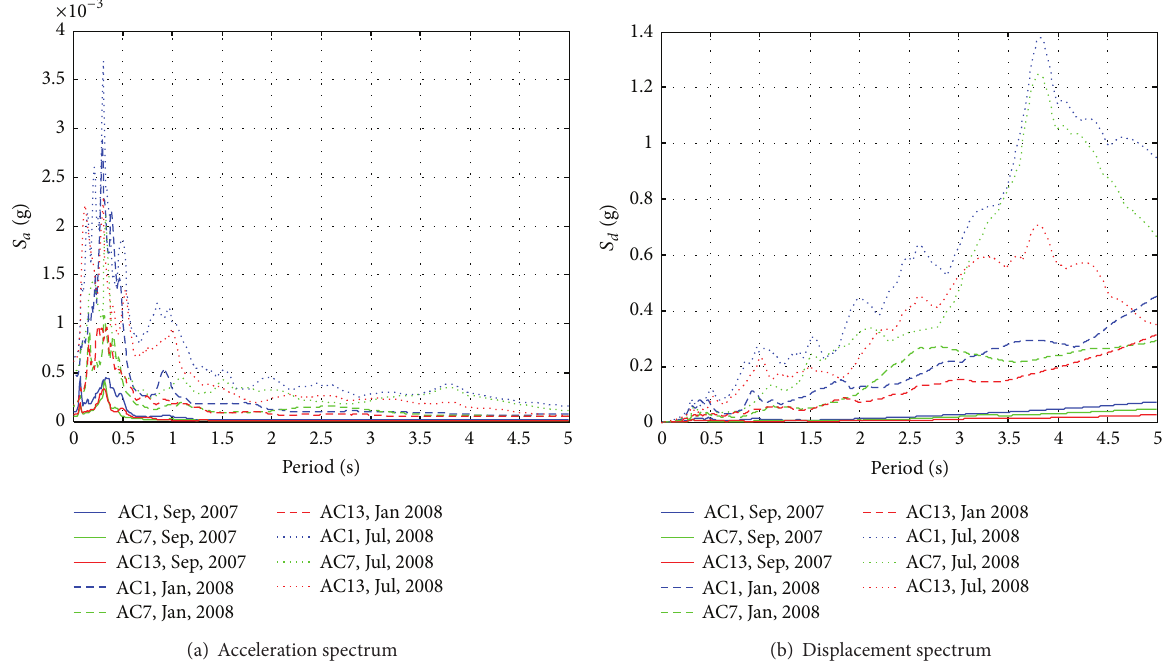
Figure 7: Spectrum response for the bridge monitoring points selection at base, healthy, and damage